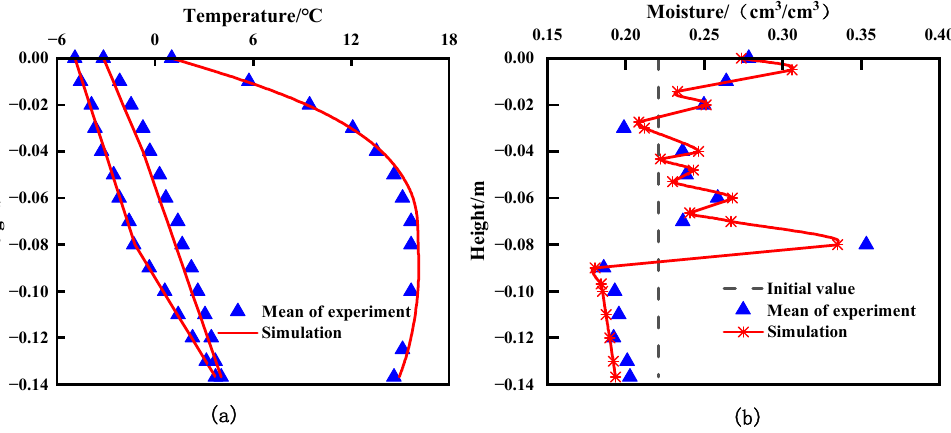
Figure 7. Comparison of simulation and experiment. ( a ) Field of temperature; ( b ) Field of moisture.